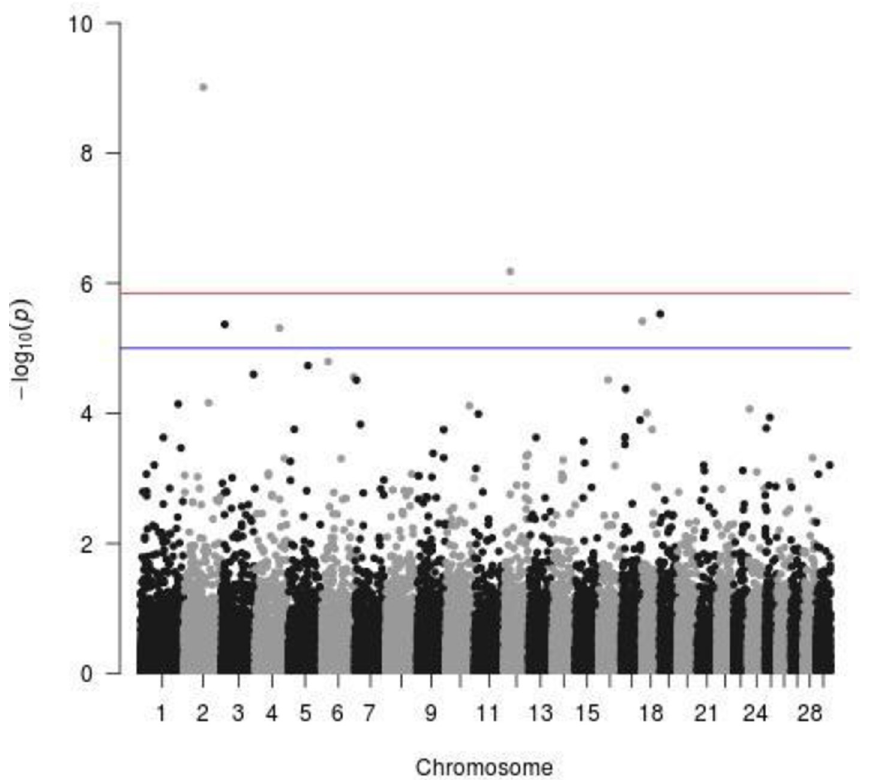
Fig 1. Significant SNPs for the dewlap size trait (blue line = indicative threshold–log10(p) = 5; red line = Bonferroni threshold–log10(p) = 5.86).